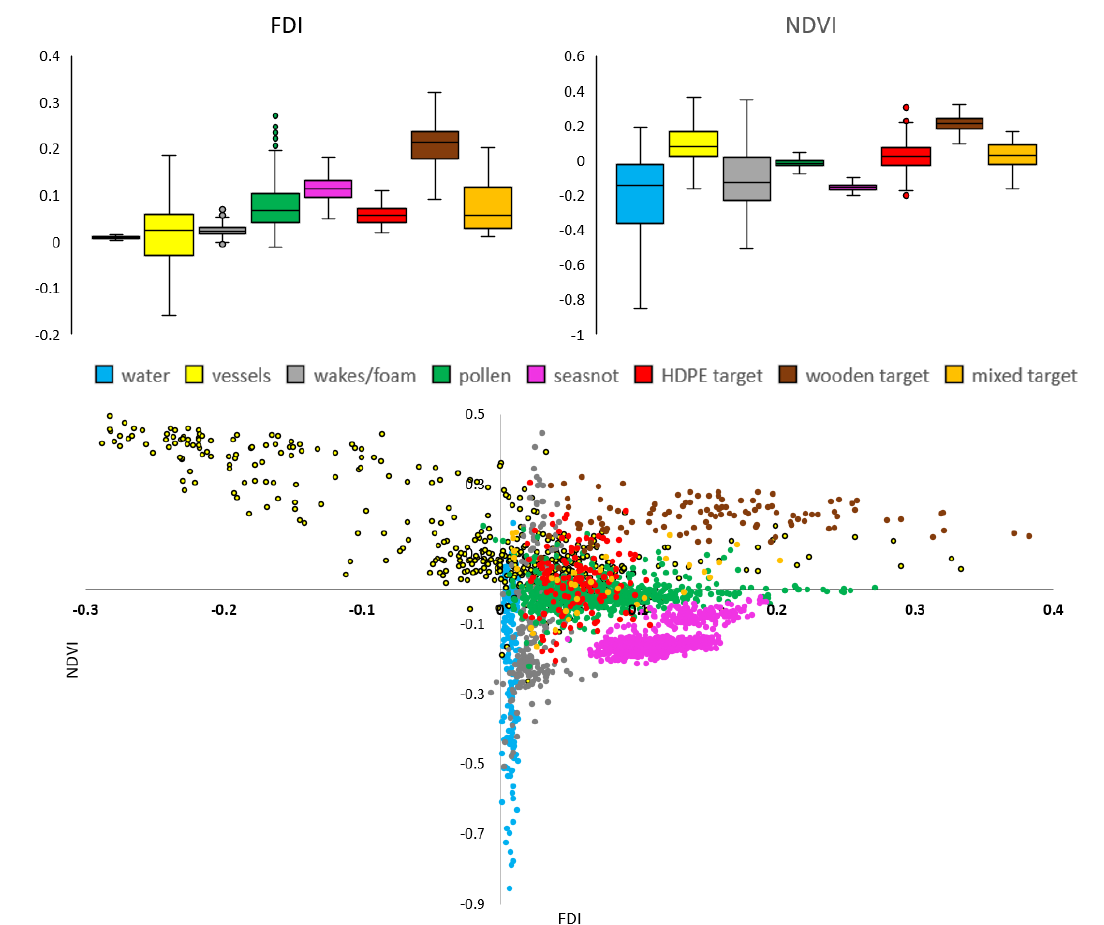
Figure 9. FDI and NDVI box and scatter plots for the different classes.